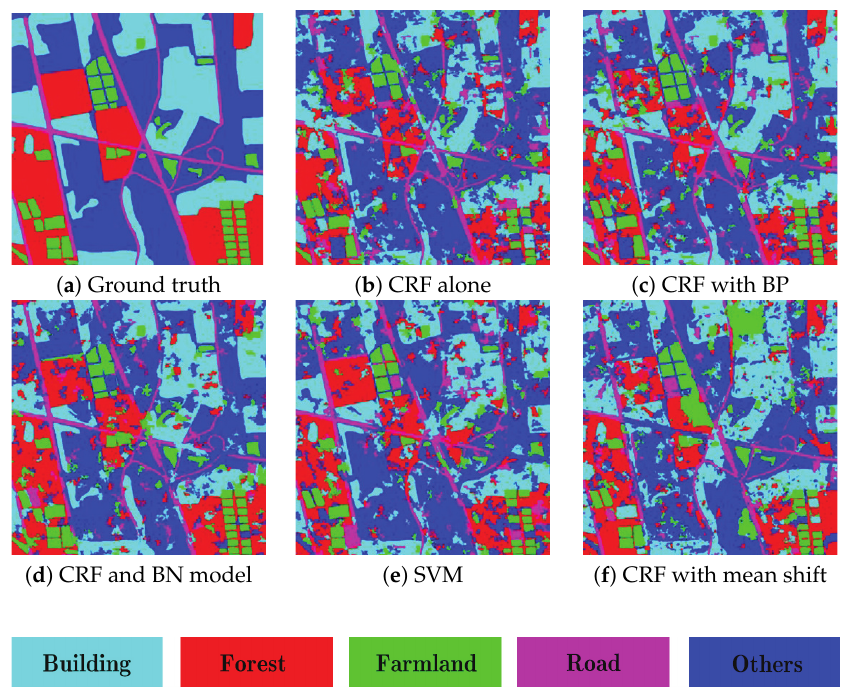
Figure 10. Classification results of TerraSAR image. ( a ) The ground truth; ( b – d ) the results by the CRF model alone, CRF with boundary prior knowledge, CRF and the BN model, respectively; ( e , f ) the results by SVM and CRF with mean